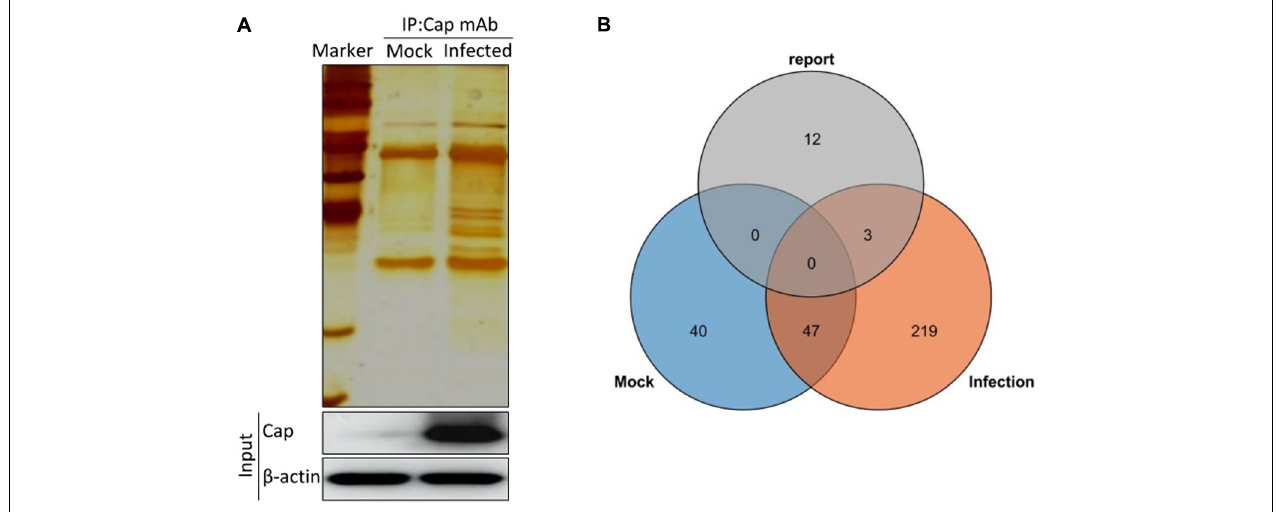
FIGURE 1 | Characterization of PCV2 Cap-interacting cellular proteins. (A) Mock infected PK-15 cells or infected with PCV2 at MOI of 1.0 were harvested 48 hpi and coimmunoprecipitation assay was performed by purified anti-Cap IgG. PCV2 Cap-interacting host proteins were eluted with protein A/G sepharose and analyzed on SDS-PAGE followed by silver staining. β -actin was used as a internal loading control. For (A) , lane 1, protein molecular weight ladder; lane 2, Mock-infected; lane 3, PCV2-infected. (B) Venn diagram of the identified protein candidates interacting with PCV2 Cap from mock infected, PCV2 infected and reported previously, respectively. Blue, orange, and gray colors indicate proteins from mock infected, PCV2 infected and reported previously, respectively. Common proteins within the data sets have been indicated in the colored intersections. Proteins have been represented as the respective NCBI gene names ( Supplementary Table S1